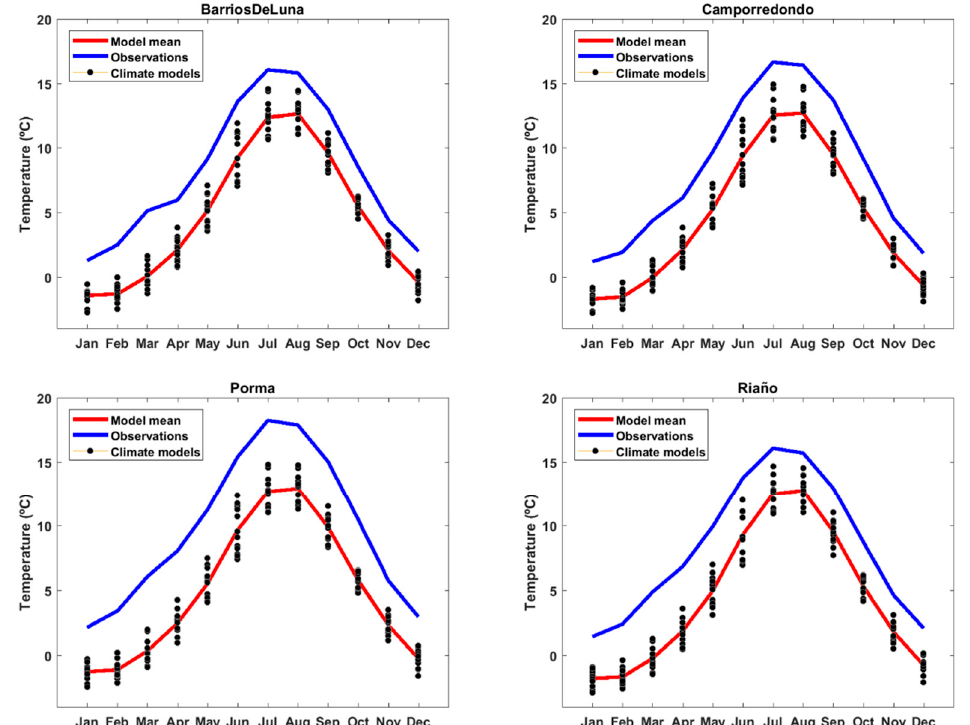
Figure 3. Comparison between monthly mean temperatures supplied by climate models and observations in the control period. Blue lines are observations. Red lines represent the median of the 12 climate models considered.